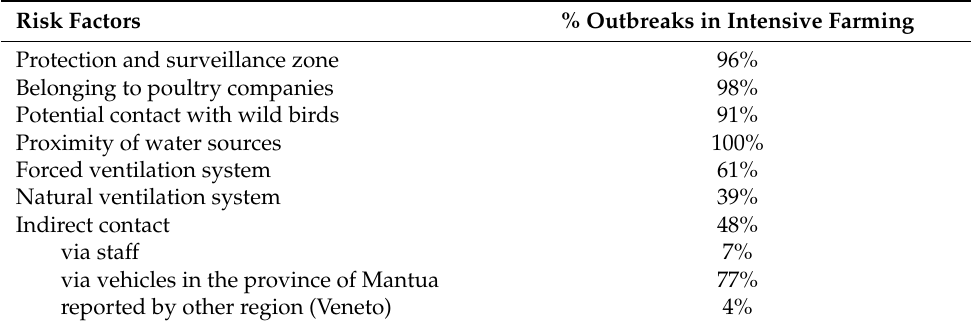
Table 2. Proportion of outbreaks in intensive farming affected by risk